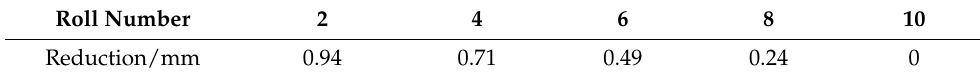
Table 3. Reduction of upper straightening roll.